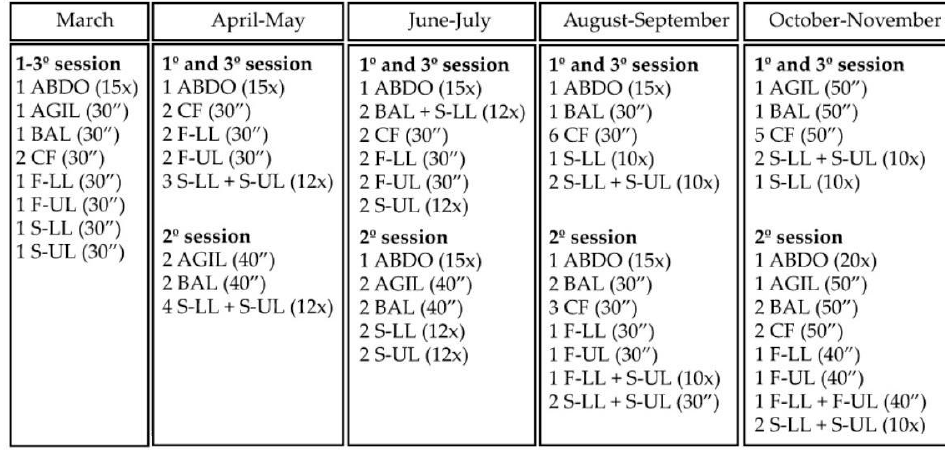
Figure 3. Periodization of the online physical training program and description of the amount of exercises of each component of physical fitness, for each session. Note. ABDO: abdomen/core, AGIL: agility; BAL: balance; CF: cardiorespiratory fitness; F-LL, lower limb flexibility; F-UL, upper limb flexibility; S-LL: lower limb strength; S-UL: upper limb strength; x: repetitions; ″ : seconds. Microcycles in each macrocycle have the same objectives, microcycles 1 and 2 were performed on Monday and Friday (with different exercises in each session and same volume), microcycle 3 occurred on Wednesday (with different exercises and volume of microcycles 1 and 2).